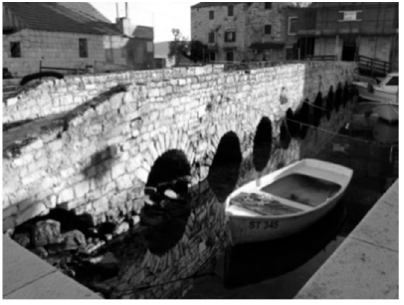
Figure 4. Kaštilac, Kaštel Gomilica (B1).